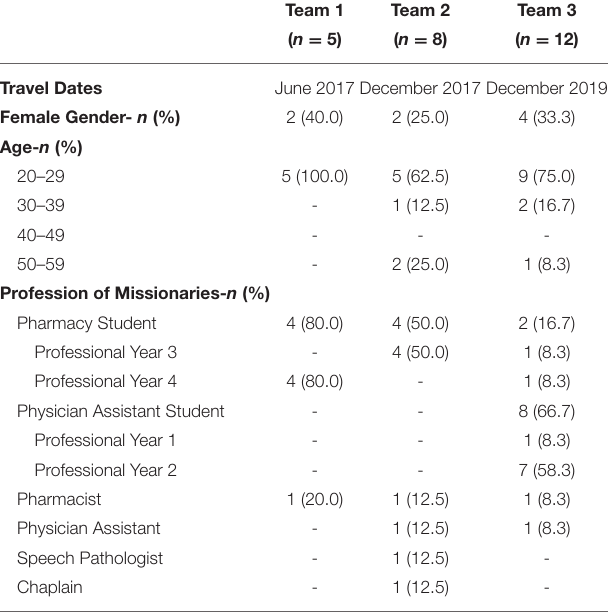
TABLE 1 | Mission